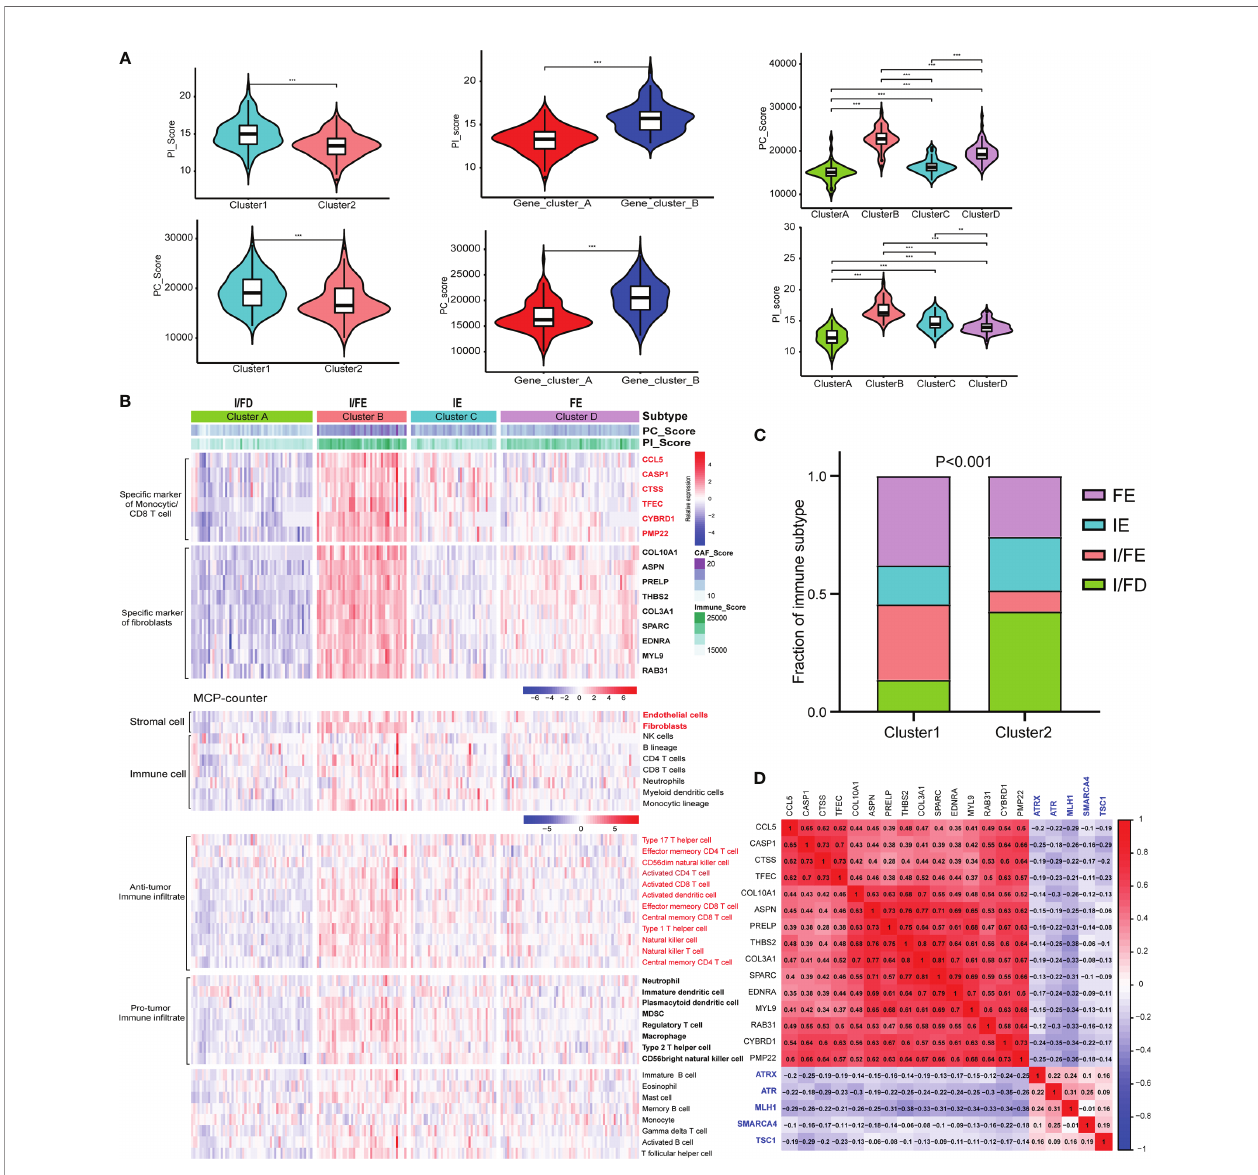
FIGURE 4 | (A) Differences in the PI_Score/PC_Score between two-pathway-related molecule patterns (left). The differences in the PI_Score/PC_Score between gene_cluster_A and gene_cluster_B (middle). The differences in the PI_Score/PC_Score in the four subtypes based on the speci fi c cell-related markers. (B) The heatmap to indicate the relative expression of speci fi c markers among the four subtypes. Heatmap of ssGSEA scores of gene sets indicative of speci fi c immune cell populations among the four subtypes. (C) The proportion of the four subtypes in the two patterns of pathway-related molecules. (D) Hierarchical clustering analysis was conducted by Pearson ’ s correlation coef fi cient between the cell-related genes and the fi ve-pathway-related molecules. P values <0.05 were considered signi fi cant (ns, P > 0.05; *, P < 0.05; **, P < 0.005; ***, P <